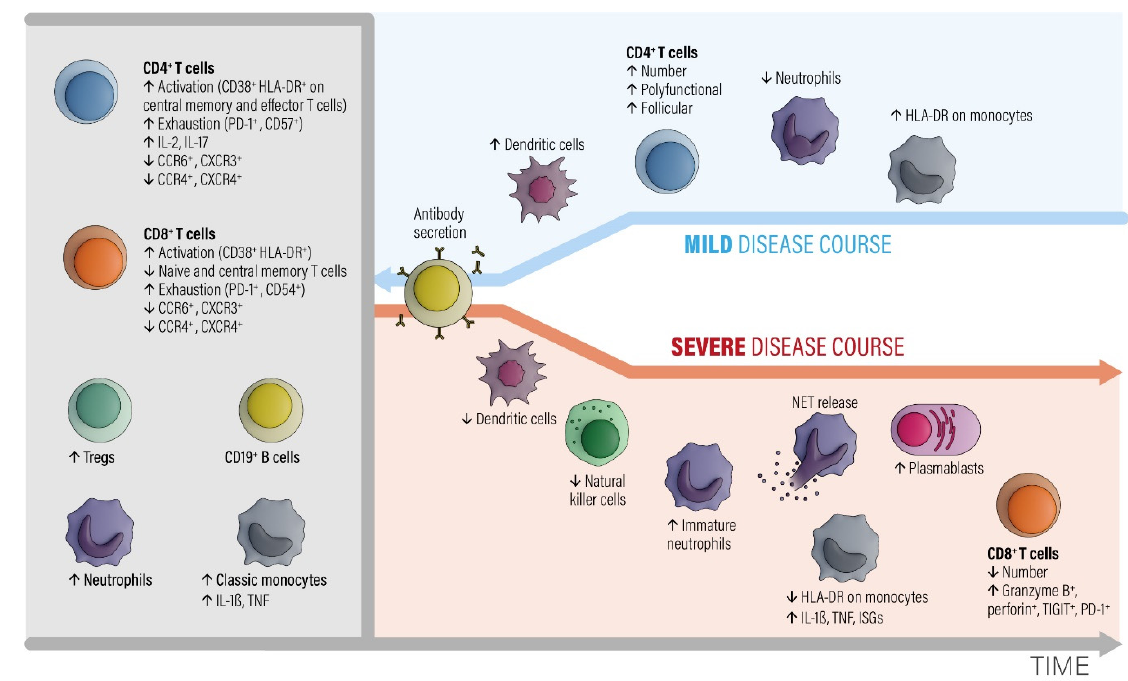
Figure 1. The involvement of different classes of immune cells mediating different courses of COVID-19 during development of the disease, modified from ref. [27]. Abbreviations: CCR = C-C chemokine receptor. CTLA-4 = cytotoxic T-lymphocyte protein 4. CXCR = C-X-C chemokine receptor. HLA-DR = HLA DR isotype. IL = interleukin. ISGs = interferon-stimulated genes. NETs = neutrophil extracellular traps. PD-1 = programmed cell death 1. TNF = tumor necrosis factor. Tregs = regulatory T cells. Modified from [27].